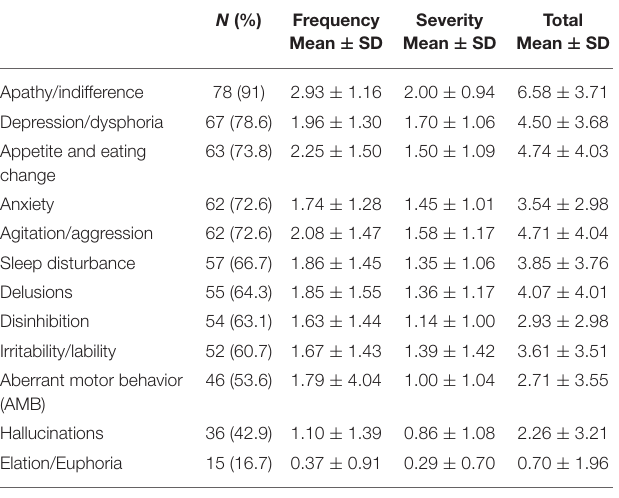
TABLE 2 | Frequency and severity of neuropsychiatric symptoms.